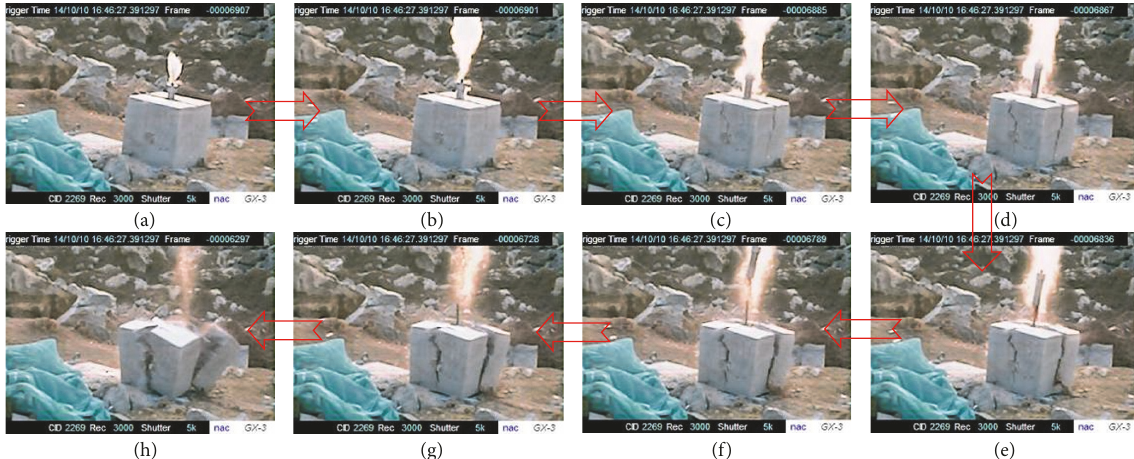
Figure 10: The process of pressured water coupling blasting in the A2B1C2 case: (a) No. 6907; (b) No. 6901; (c) No. 6885; (d) No. 6867; (e) No. 6836; (f) No. 6789; (g) No. 6728; and (h) No. 6297